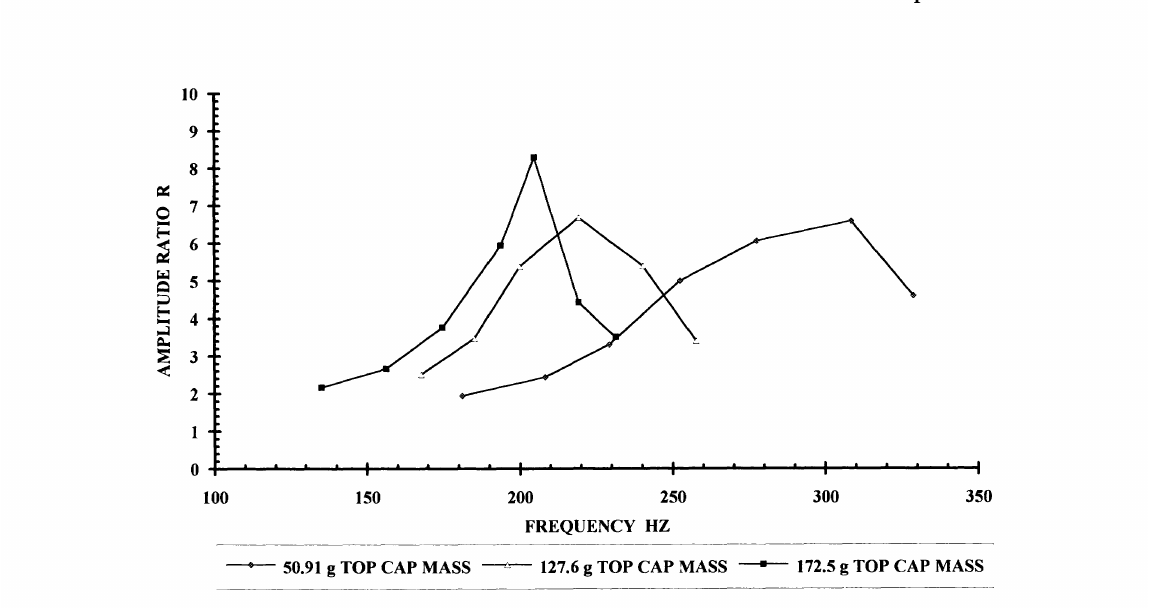
FIGURE 3 Amplification of acceleration R versus frequency: small cylinder 76 * 38 mm; 6.1 % mois ture; 1500 kg/m 3; particle size <350 JLm; no membrane; normal load